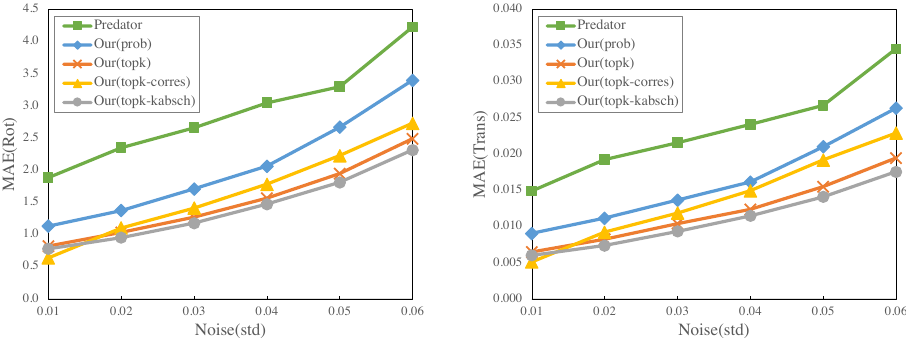
Figure 6. Results on additive noise and cropped data. It displays the MAE of rotation ( ◦ ) and translation versus the standard deviation of